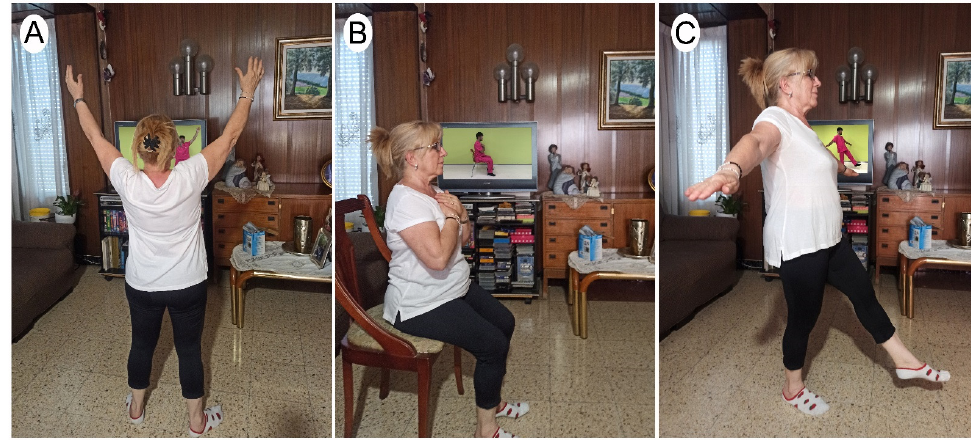
Figure 1. Three examples of exercises from ViviFail program. ( A ) Example of warm up; ( B ) example of strength exercise; ( C ) example equilibrium. The warm-up included breathing exercises, joint mobility, and walking exercises. Two weekly sessions focused on upper/lower-extremity strength and balance exercises. Bouts of three sets of 10–12 repetitions per exercise were performed. Main exercises used were double-legged squats. Help (using a chair) and weight (using a bottle or a box) were used as progressions. Knee extensions with and without weights or to raise a bottle with the hands as high as possible were strength exercises. Balance exercises consisted of sin- gle-legged and double-legged jumps. Progressions included doing exercises with eyes closed. The remaining session focused on interval training with work times of 20–40 s and rest times of 40–60 s. The intensity of the workouts ranged between 6 and 7 on the modified Borg scale (0–10), i.e., moderate to vigorous intensity [44]. Walking and going up and down stairs were the exercises most often used at this stage. The cool-down phase consisted of muscle group stretching, walking, and breathing exercises. 2.6. Study Procedure After satisfying the eligibility criteria and agreeing to participate in the study, each subject was randomly assigned to the experimental or control group as described. During all evaluations and interventions, patients wore a pulse oximeter (Masimo MightySat ® Rx) to monitor the safety of the procedure. The recommendations for training performed in people with COVID-19 were followed [15]. If any of the following conditions were met, it was immediate reason to stop exercise: - Respiratory frequency < 40 breaths per minute; - Heart rate < 120 beats/minute in resistance exercises and < 140 beats/minute in in- tervallic exercises; - Sp02 < 90%. Outcomes were assessed at the beginning of the study, at the end of the intervention, and one month after the intervention by an assessor blinded to the treatment allocation of the subjects. 2.7. Sample Size Calculation The Gpower 3.1 software (Franz Faul, Universität Kiel, Kiel, Germany) was used for sample size calculation. It was calculated based on the Silva et al. [45] study, with an ef-